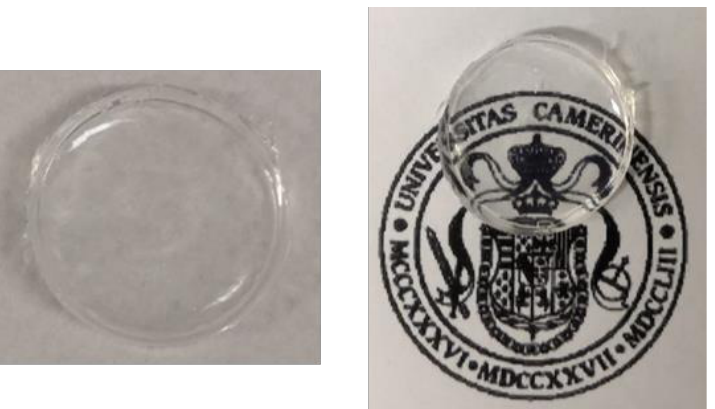
Figure 1. Silica-based xerogel monolith obtained by sol-gel method. In this procedure, the addition of DMF, as drying control chemical additive (DCCA), permitted to obtain a crack-free monolith. Despite that the procedure involved HCl, DMF decreased the acidity of the precursor solution by acting as hydrogen bond